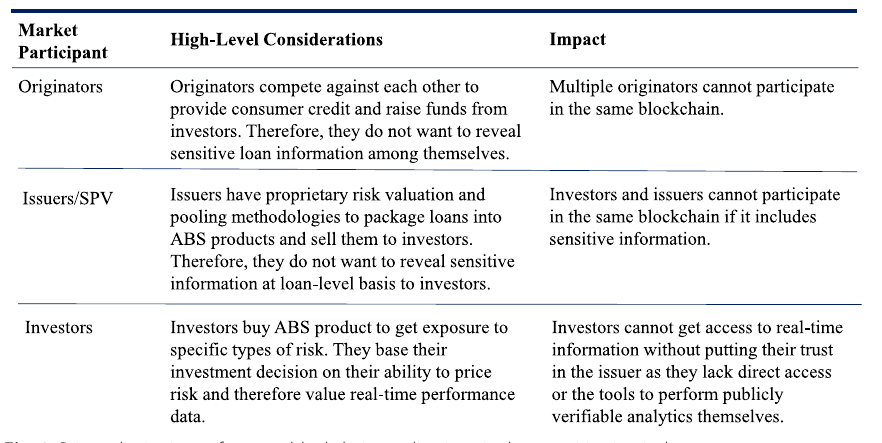
Fig. 2 Privacy limitations of current blockchain applications in the securitization industry